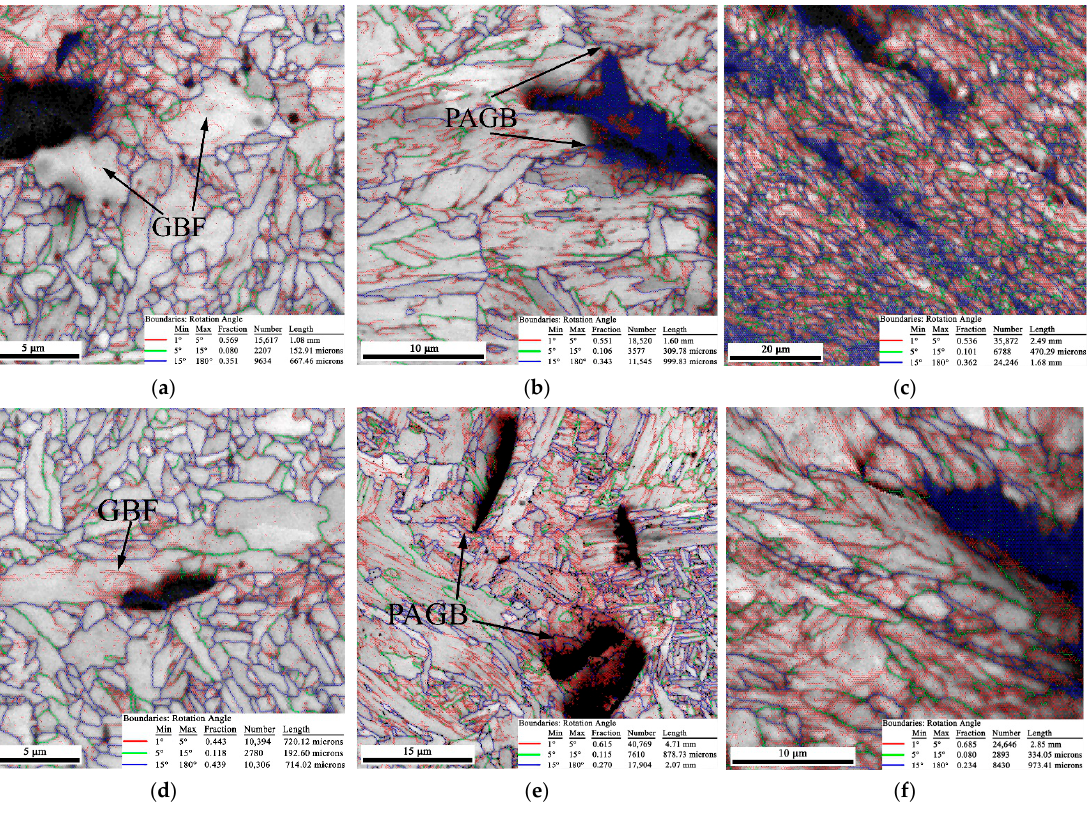
Figure 7. The EBSD map of the secondary crack obtained from the welded sample: ( a ) WZ; ( b ) CGHAZ; and ( c ) SCHAZ, and PWHT samples: ( d ) WZ; ( e ) CGHAZ; and ( f ) SCHAZ.